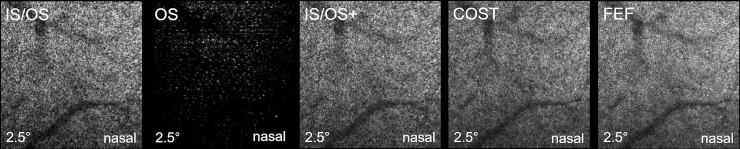
The 5 different cone planes, depicted at 2.5°nasal in a 26yo healthy male.Inner segment outer segment junction zone (IS/OS) shows a dense mosaic of hyper-reflective dots. Cone outer segments (OS) show significantly less hyperreflective dots beside several blurry and weak signals. Combination of IS/OS and OS (IS/OS+) resembles mainly the IS/OS mosaic with some additional signals from the OS below (see also S1 File). Dots from the mosaic of the cone outer segment tips (COST) are better distinguishable compared to the IS/OS. Through integration of all cone signals to a full en-face image (FEF), the most complete appearance of the cone mosaic is achieved. S1 Fig gives a complete overview of all 8 regions imaged in this eye.